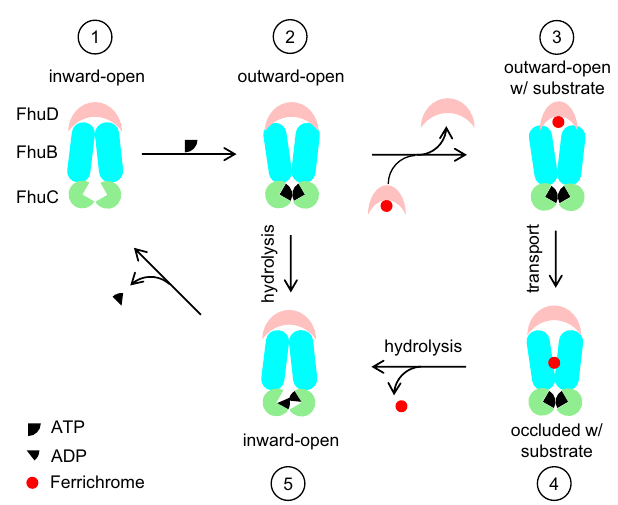
Fig. 5 Schematic representation of the transport cycle of FhuCDB. Without the substrate, FhuCDB cycles through inward-open (states 1, 5) and outward-open (state 2) upon ATP binding, ATP hydrolysis, and ADP release. With the substrate, FhuD in FhuCDB (state 2) is replaced by the substrate-loaded FhuD (state 3). The substrate is then released to FhuB and transferred down the translocation pathway (state 4). After ATP hydrolysis, FhuB opens the cytosolic gate and releases the substrate into the cytosol (state